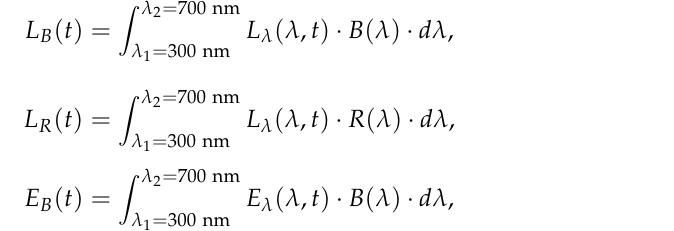
Figure 16. Measurement of illumination parameters to determine ASLODE on board the Airbus A- 319CJ.